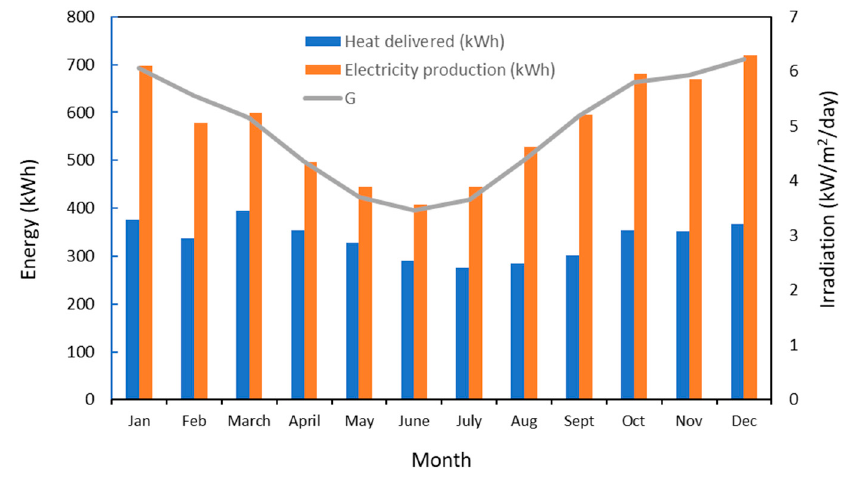
Figure 6. Monthly generation of electricity and heat delivered of the rooftop PVT system.